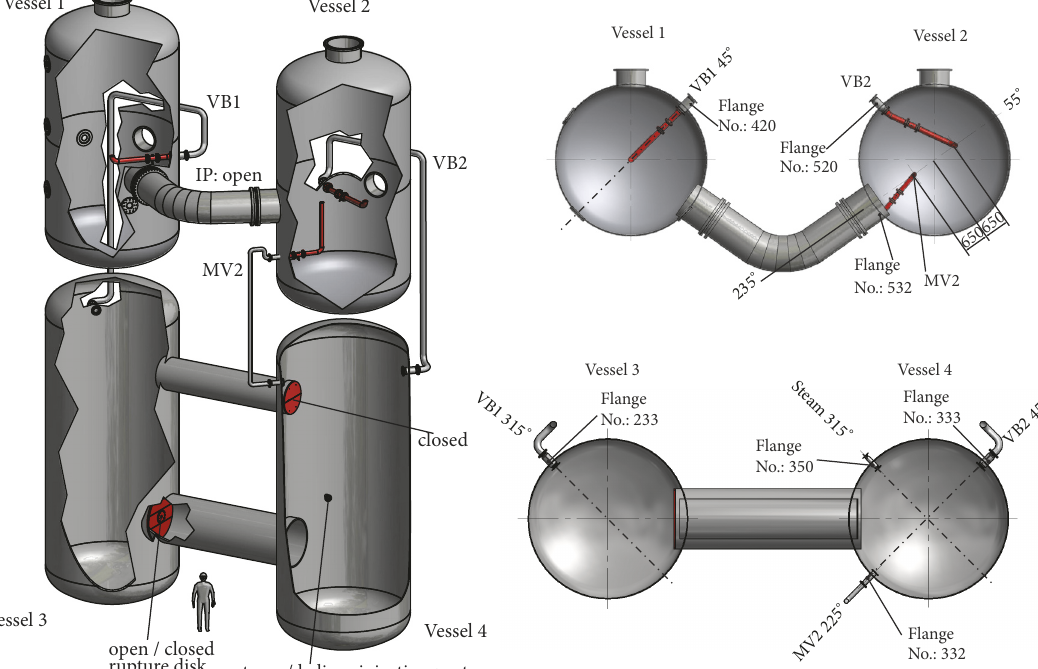
Figure 2: Different views of the four PANDA vessels illustrating the configuration and the pipes between the vessels as used for the HP6 series. A 3D view is shown on the left and a horizontal cross section through Vessels 1 and 2 at the top and horizontal cross section through Vessels 3 and 4 at the bottom on the right